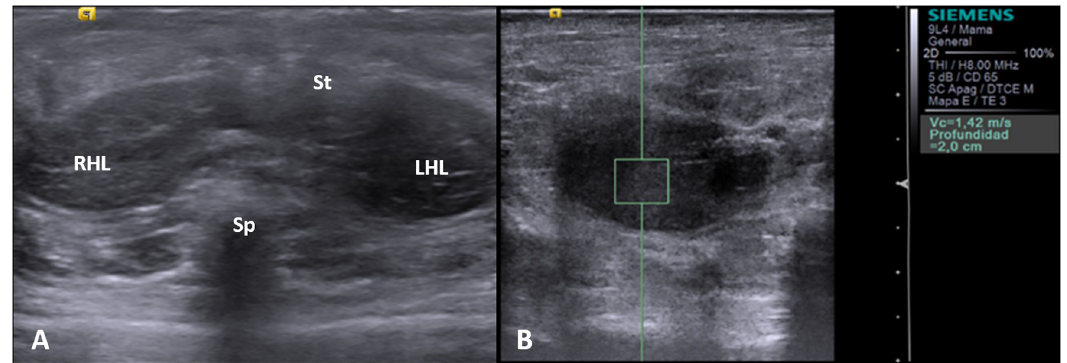
Fig 2. A , In vivo ultrasound image of the upper abdominal quadrants. RHL: right hepatic lobe; LHL: left hepatic lobe; St: Stomach; Sp: Spine. B , In vivo assessment using the ARFI technique.